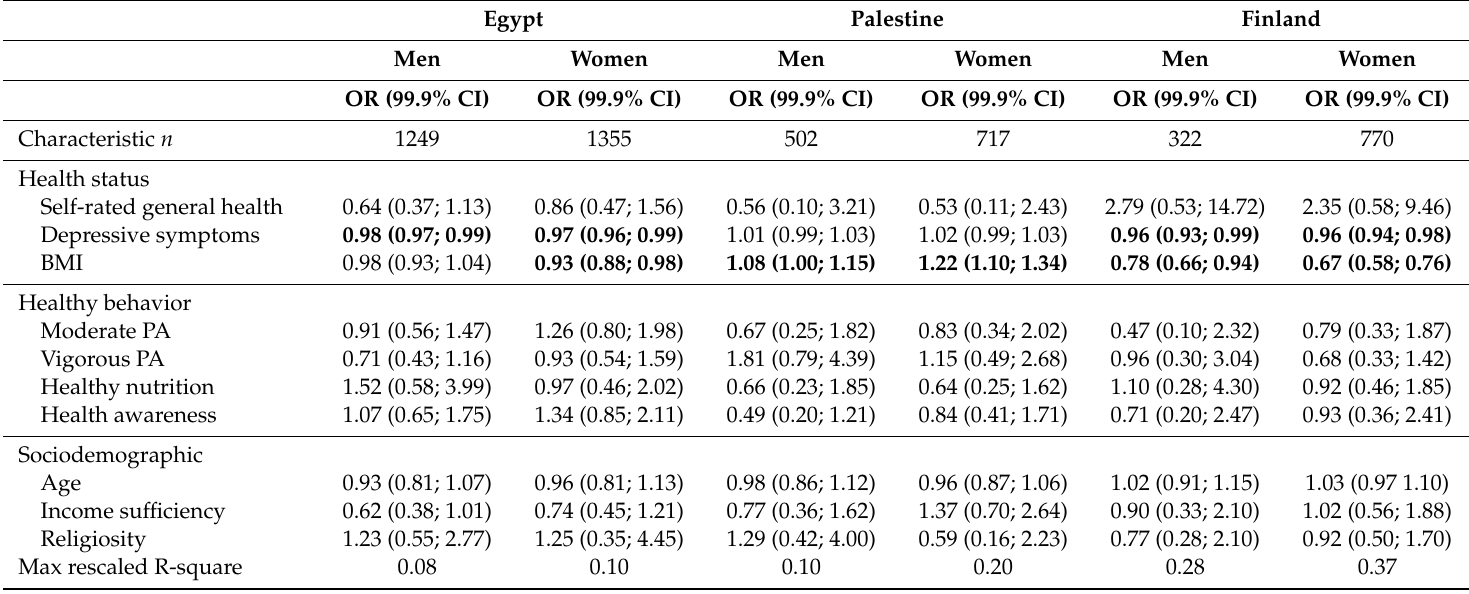
Table 3. Multivariable logistic regression of health status, healthy behavior, and sociodemographic characteristics on weight satisfaction * , stratified by country and sex.